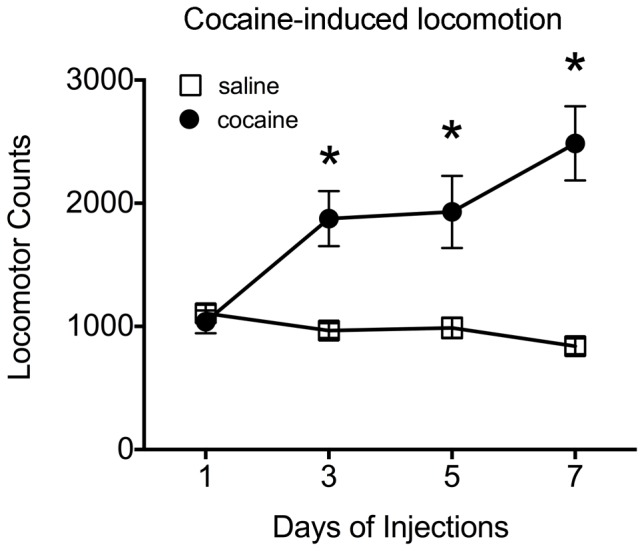
Locomotor response to a sensitizing regimen of cocaine.This plot shows locomotor activity in response to repeated injections of cocaine (10 mg/kg, i.p.) or saline. Closed circles represent animals receiving injections of cocaine; open squares indicate animals receiving injections of saline. Data are shown as group averages (± SEM); *p<0.05 compared to saline.